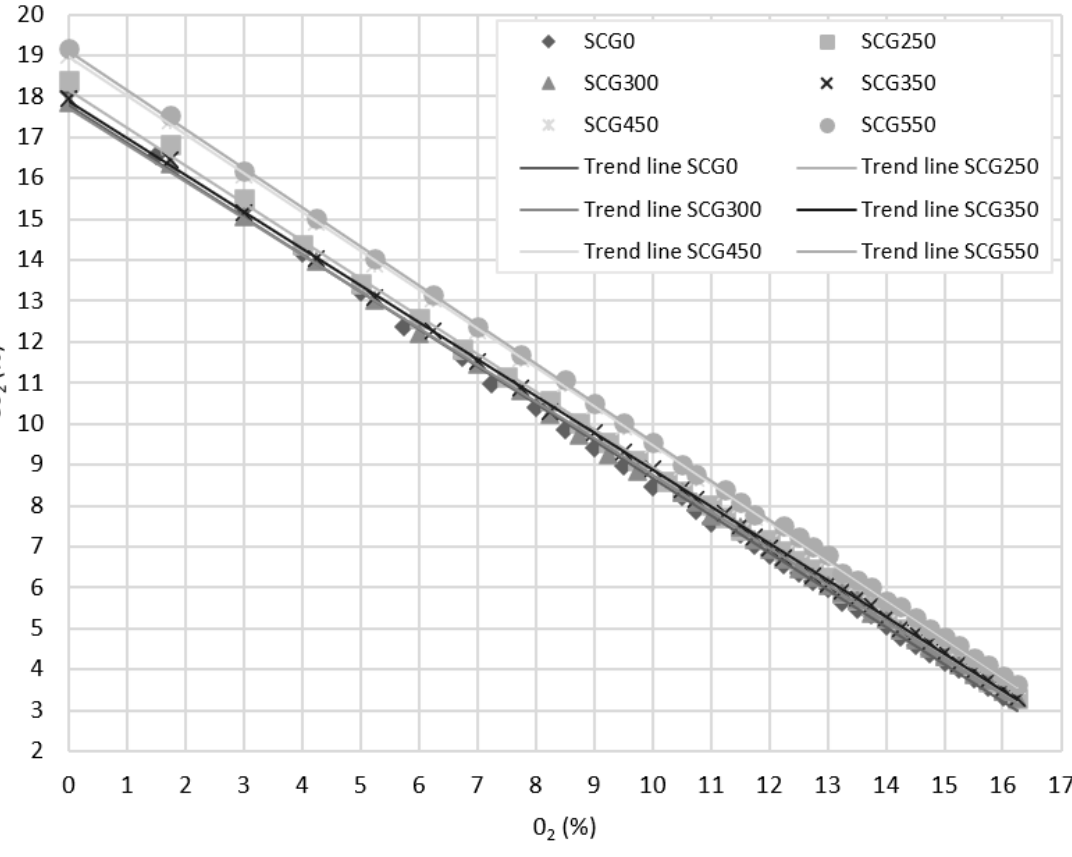
Figure 5. Coffee oxygen share dependence on carbon dioxide share.